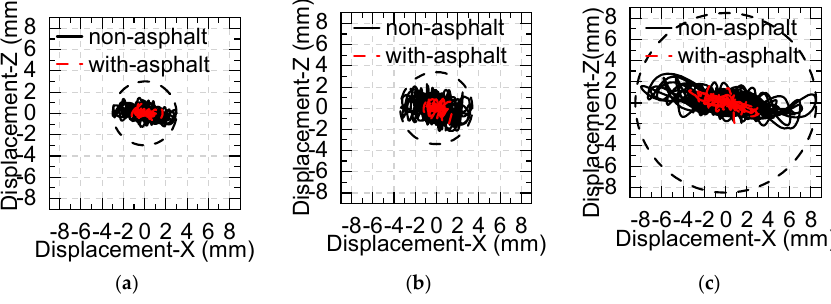
Figure 17. Influence of asphalt on displacement: ( a ) test condition Nos. 7, 19; ( b ) test condition Nos. 8, 20; ( c ) test condition Nos. 9, 21.